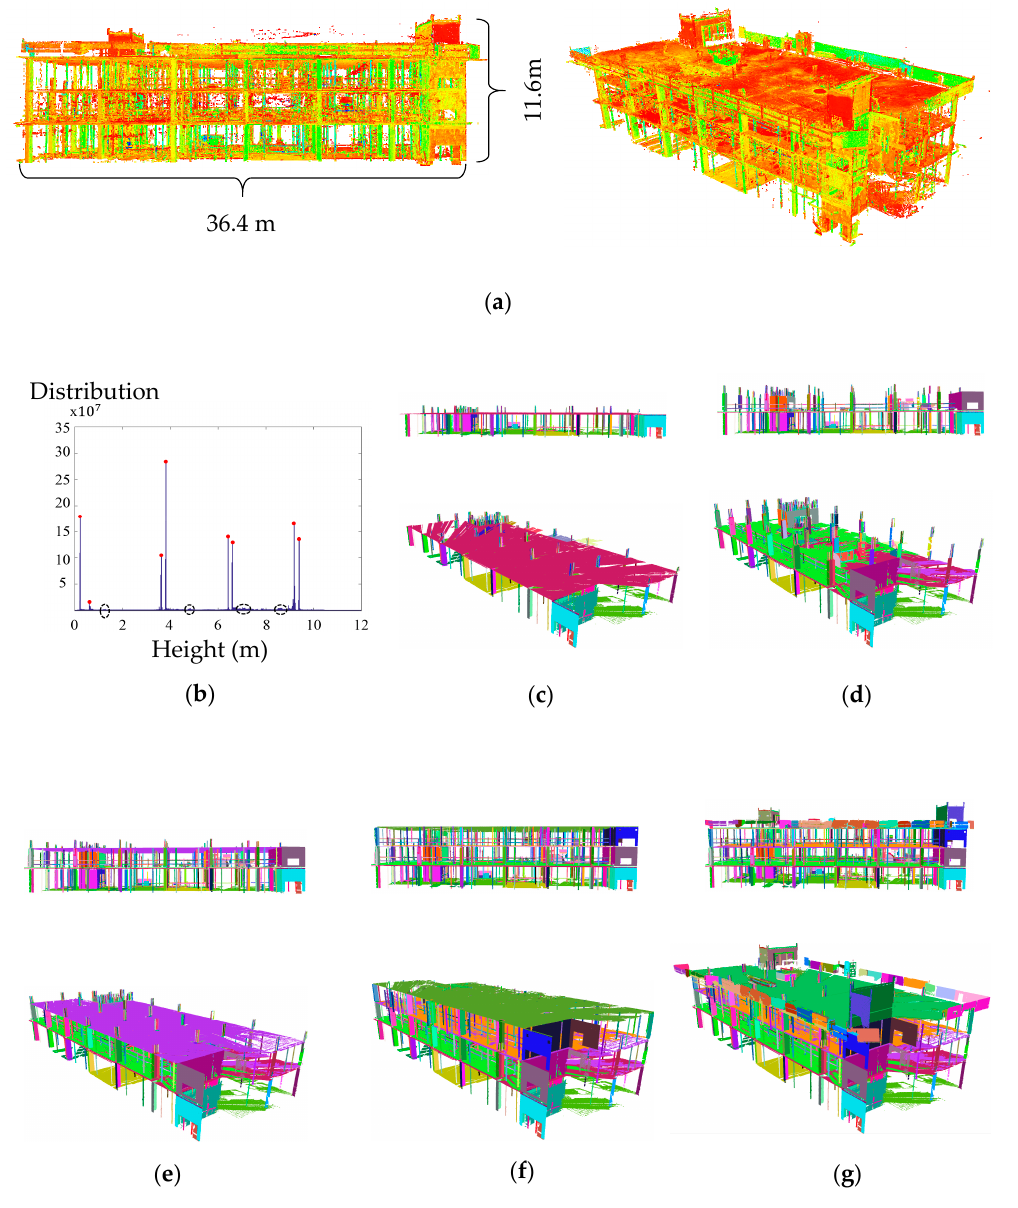
Figure 12. ( a ) The point clouds of the first four floors (all six epochs) registered to the reference coordinate system; and ( b ) histogram of point height of all of the scans combined; planar and linear segmentation results (top and side views) from the accumulated points of: ( c ) Epochs 1–2; ( d ) Epochs 1–3; ( e ) Epochs 1–4; ( f ) Epochs 1–5; and ( g ) Epochs 1–6.